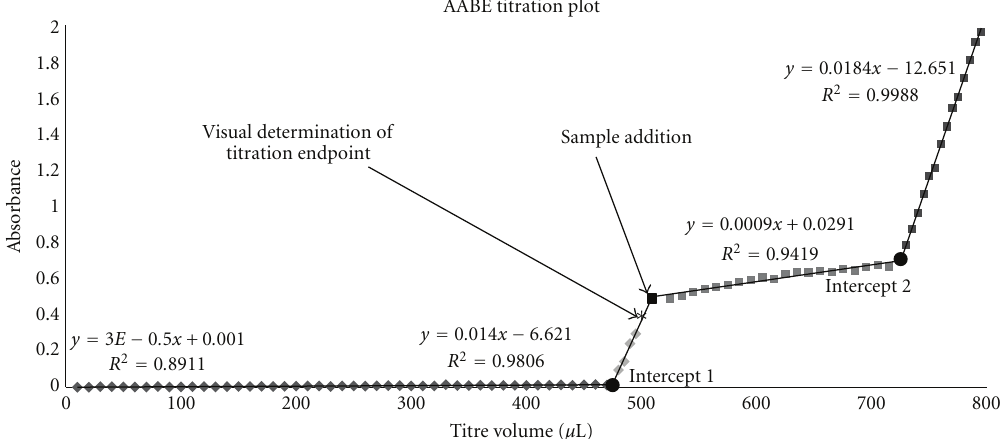
Figure 1: AABE titration plot, recorded at 520